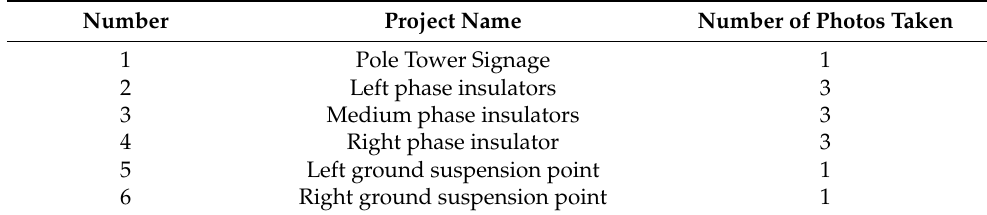
Table 2. AC single-return linear tower refinement inspection